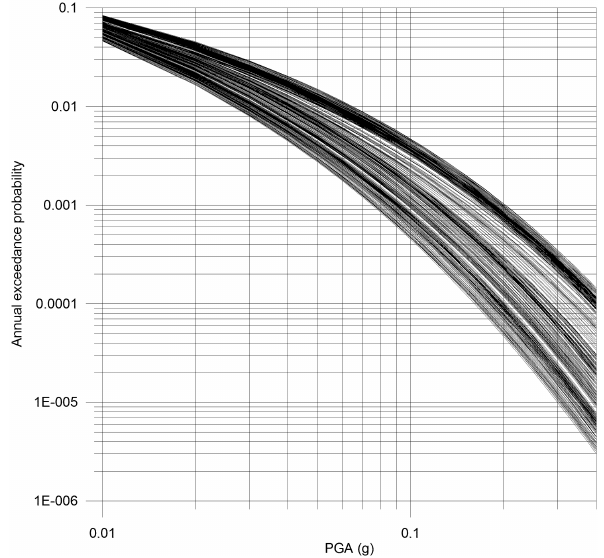
Figure 6. Seismic hazard (mean) curves for the locations of the dikes along the Rhine River. Each curve corresponds to one dike